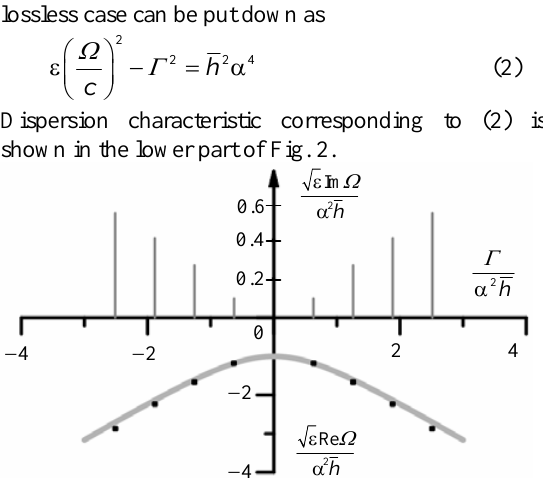
Fig. 2. Dispersion curve of the surface wave. Dots mark the surface-wave resonator modes at  , lines in the upper part indicate the losses of these